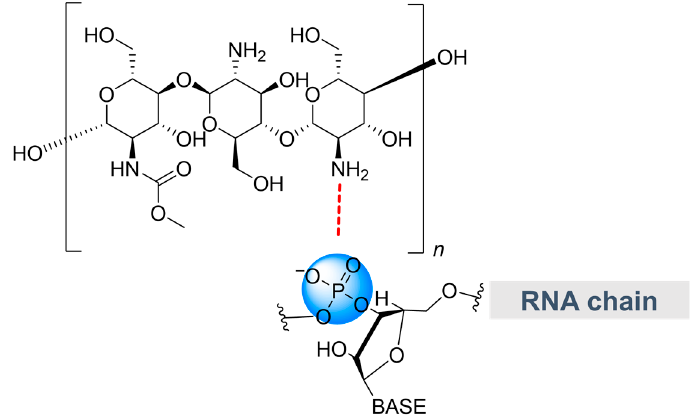
Figure 5. Binding interaction (dotted line in red) between polymeric chitosan and RNA. Color image available online.